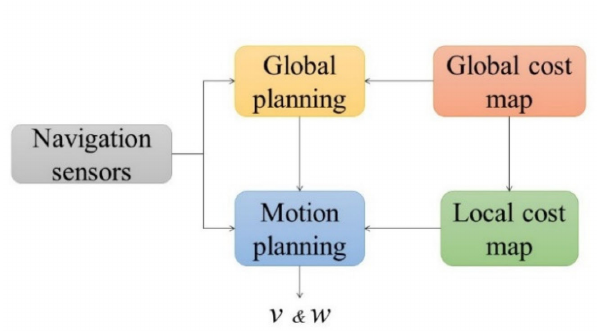
Figure 7. Flow diagram of the planning